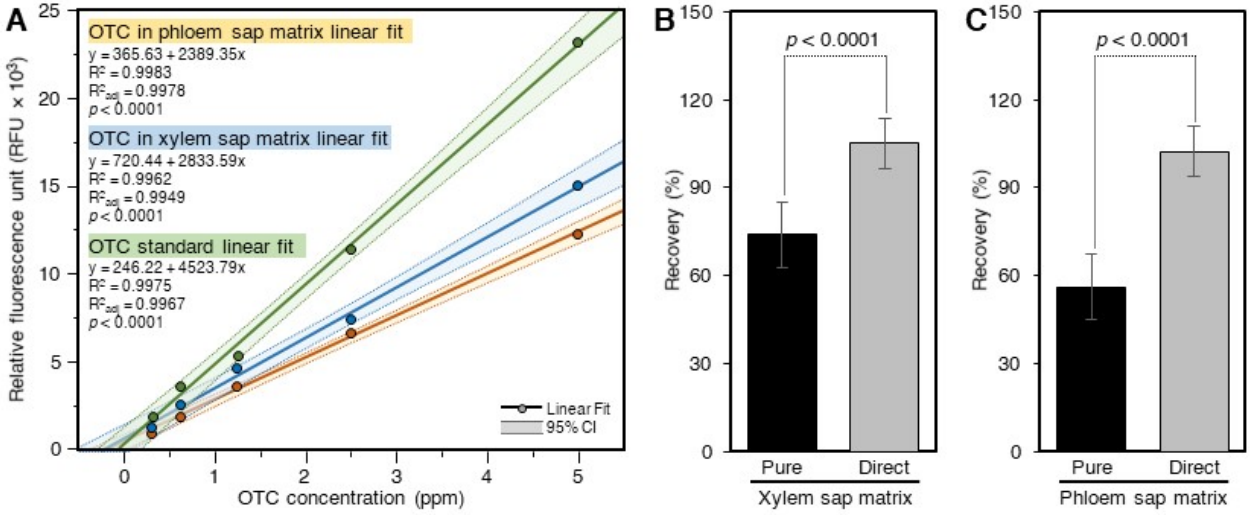
Figure 5. Recovery of OTC from spiked citrus xylem and phloem saps by direct analysis (without SPE). ( A ) Standard curves of OTC in 60% methanol and citrus xylem and phloem sap. The standard curves in the sap matrices were prepared by spiking the xylem and the phloem sap with OTC and analyzing it directly after being diluted with 60% methanol. ( B ) Recovery of OTC from spiked ‘ Ca. L. asiaticus’-infected and healthy xylem sap as calculated using the pure OTC standard and the standards prepared in the xylem sap matrix and measured directly without the SPE. ( C ) Recovery of OTC from spiked phloem sap as calculated using the pure OTC standard and the standards prepared in the phloem sap matrix and measured without the SPE. Data are the means ± SD of five replicates ( n = 5). Values with p -values < 0.05 are significantly different using a two-tailed student t -test.